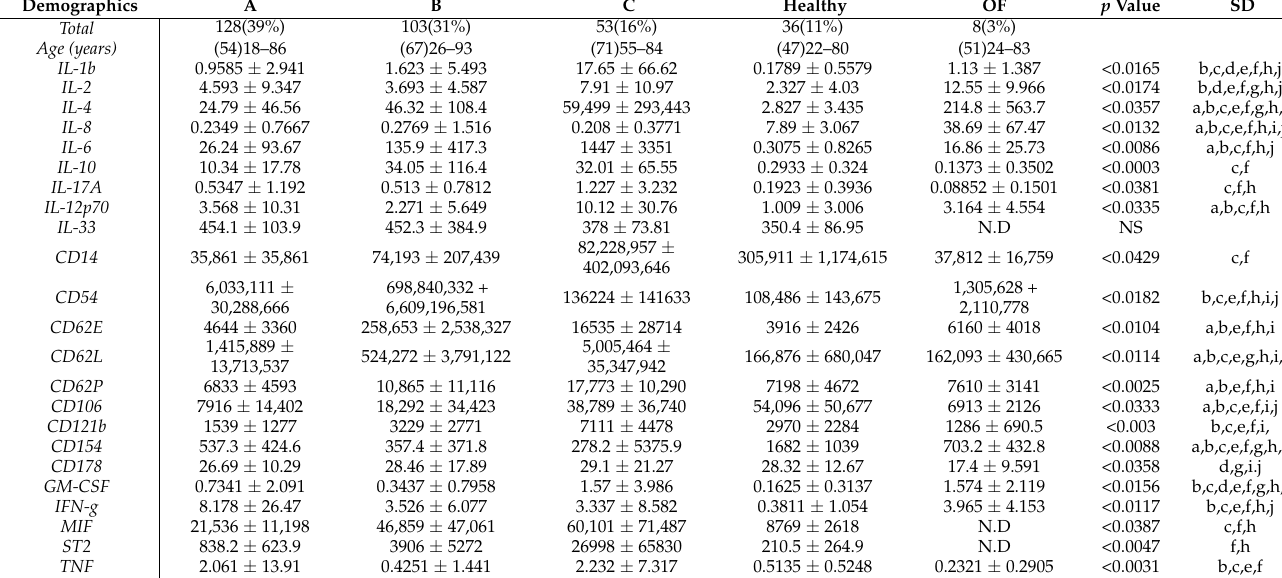
Table 1. Study Cohort Summary and laboratory parameters. A, dengue without warning symptoms; B, Dengue with warning signs; C, Sever Dengue; OF, other febrile infection; Healthy, Healthy; CD14, cluster of differentiation; CD54, cluster of differentiation 54; CD62E, E-selectin;CD62L, L-selectin; CD62p, P-selectin; CD106, cluster of differentiation 106; CD121B, Cluster of Differentiation 121 β ; CD154, Cluster of Differentiation 154; CD178, cluster of differentiation 178; GM-CSF, granulocyte-macrophage colony-stimulating factor; IL-1b, Interleukin 1 beta; IL-2, interleukin 2; L-4, interleukin 4; IL-6, interleukin 6; IL-8, interleukin 8; IL-10, interleukin 10;IL-12p70, interleukin 12p70; IL-17A, interleukin 17A; IL-33, interleukin 133; IFN-g, interferon gamma; MIF, macrophage migration inhibitory factor; ST2,TNF, tumor necrosis factor. Cytokine concentration in pg/mL. Kruskal–Wallis test and Mann–Whitney test for continuous variable not-normally distributed; mean ± SD; number (percentage of total); median (minimum–maximum); N.D (no data).